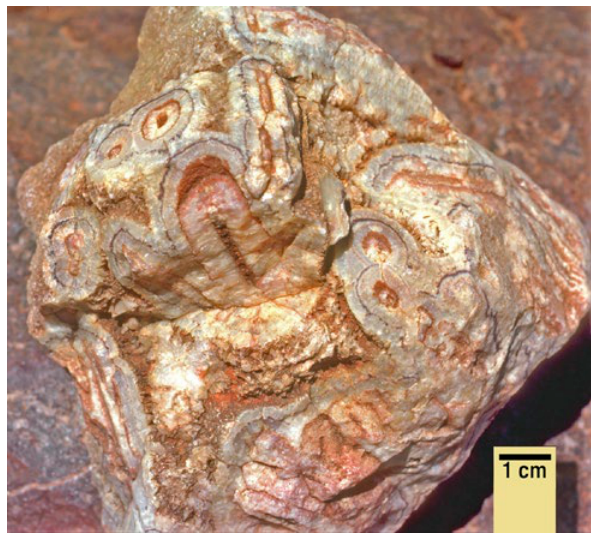
Figure 60. Concretionary polymeric silica at the precursor stage has formed round dawsonite needles grown in silica gel. It has subse- quently crystallised in a radiating spherulite-like pattern to form interfering coarse tube-like clusters of fine radiating quartz crystals along the slender dawsonite ‘needles’ from which they nucleated. This vein quartz is from Mt. Gee in the Flinders Ranges, SA.